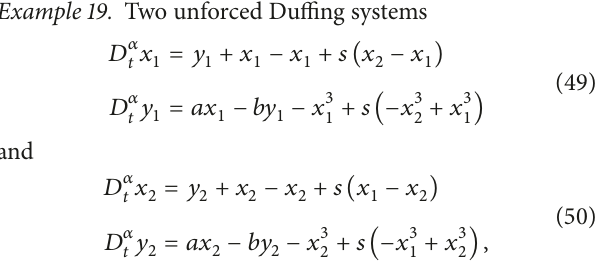
Example 19. Two unforced Duffing